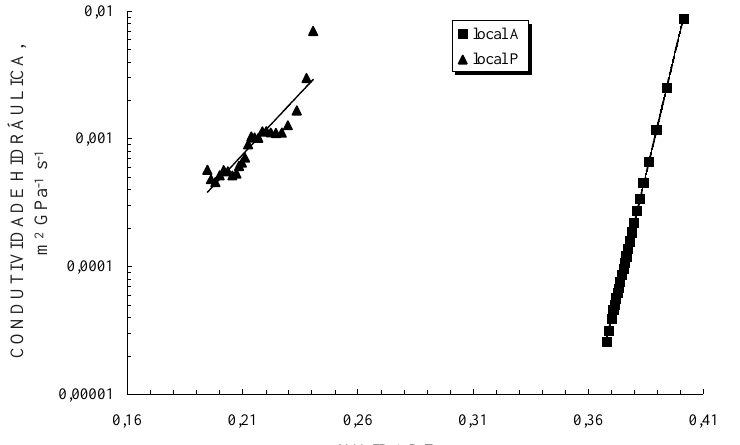
Figura 2. Condutividade hidráulica versus umidade volumétrica para o local A (0,20 m) e para o local P (0,30-0,45